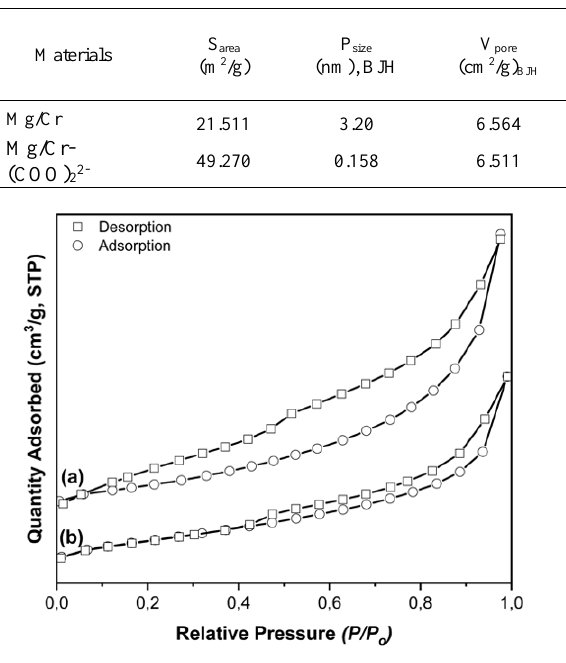
Fig. 3. BET curve Mg/Cr (a) and Mg/Cr-(COO) 22- (b)